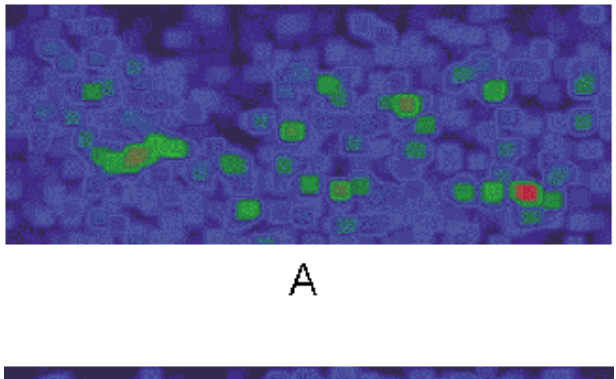
An. Acad. Bras. Cienc. ,(2001) 73